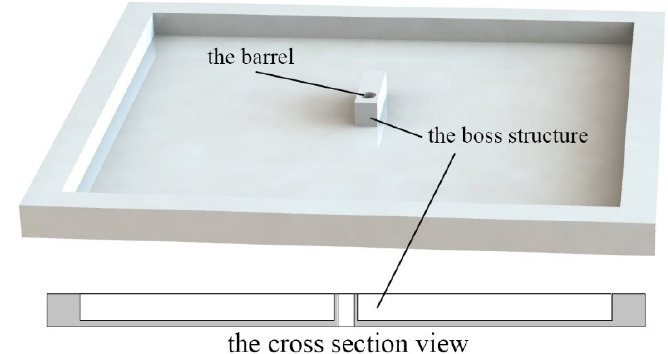
Figure 8. The structure of the barrel plate.